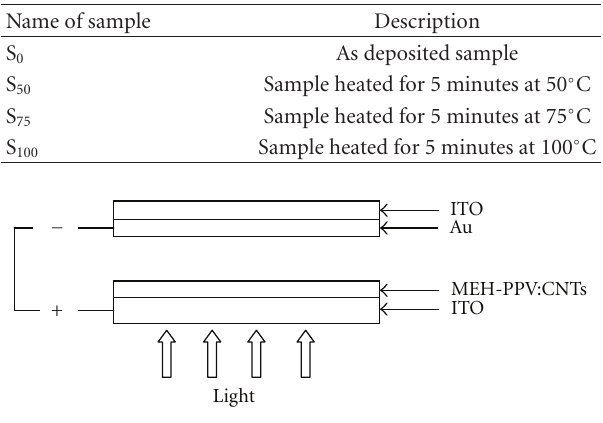
Figure 1: Structure of organic solar